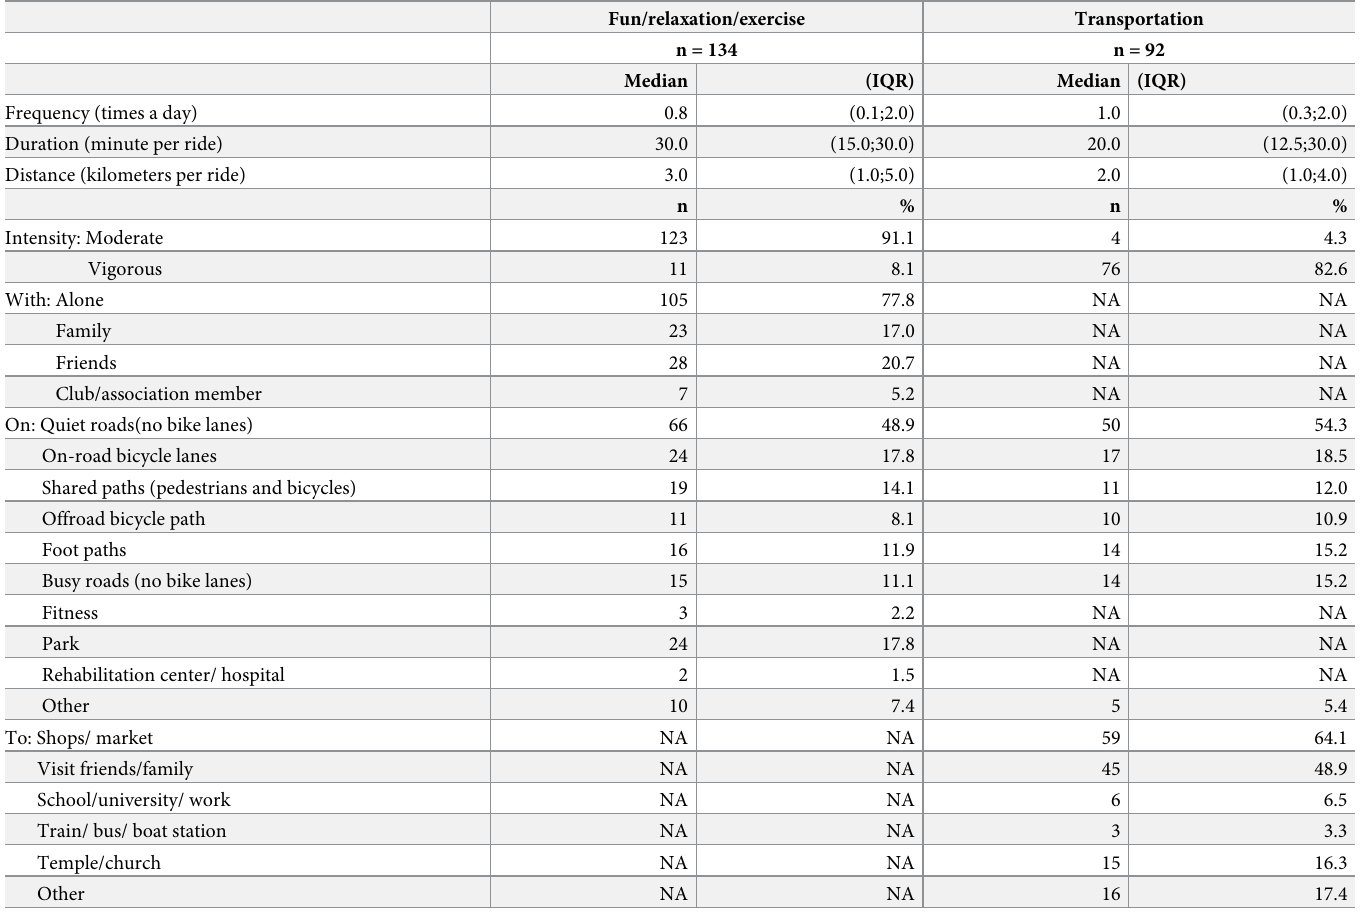
Table 4. Cycling intensity, frequency, path, and destination according to the purpose of